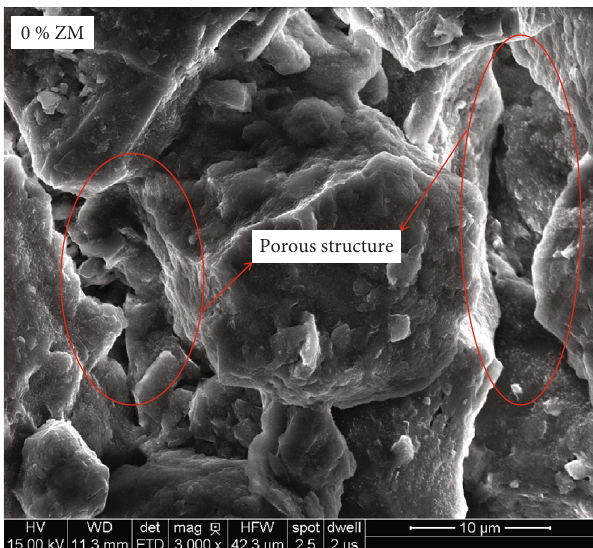
Figure 9: Micrograph of saline soils with 0% ZM after seven days of curing.